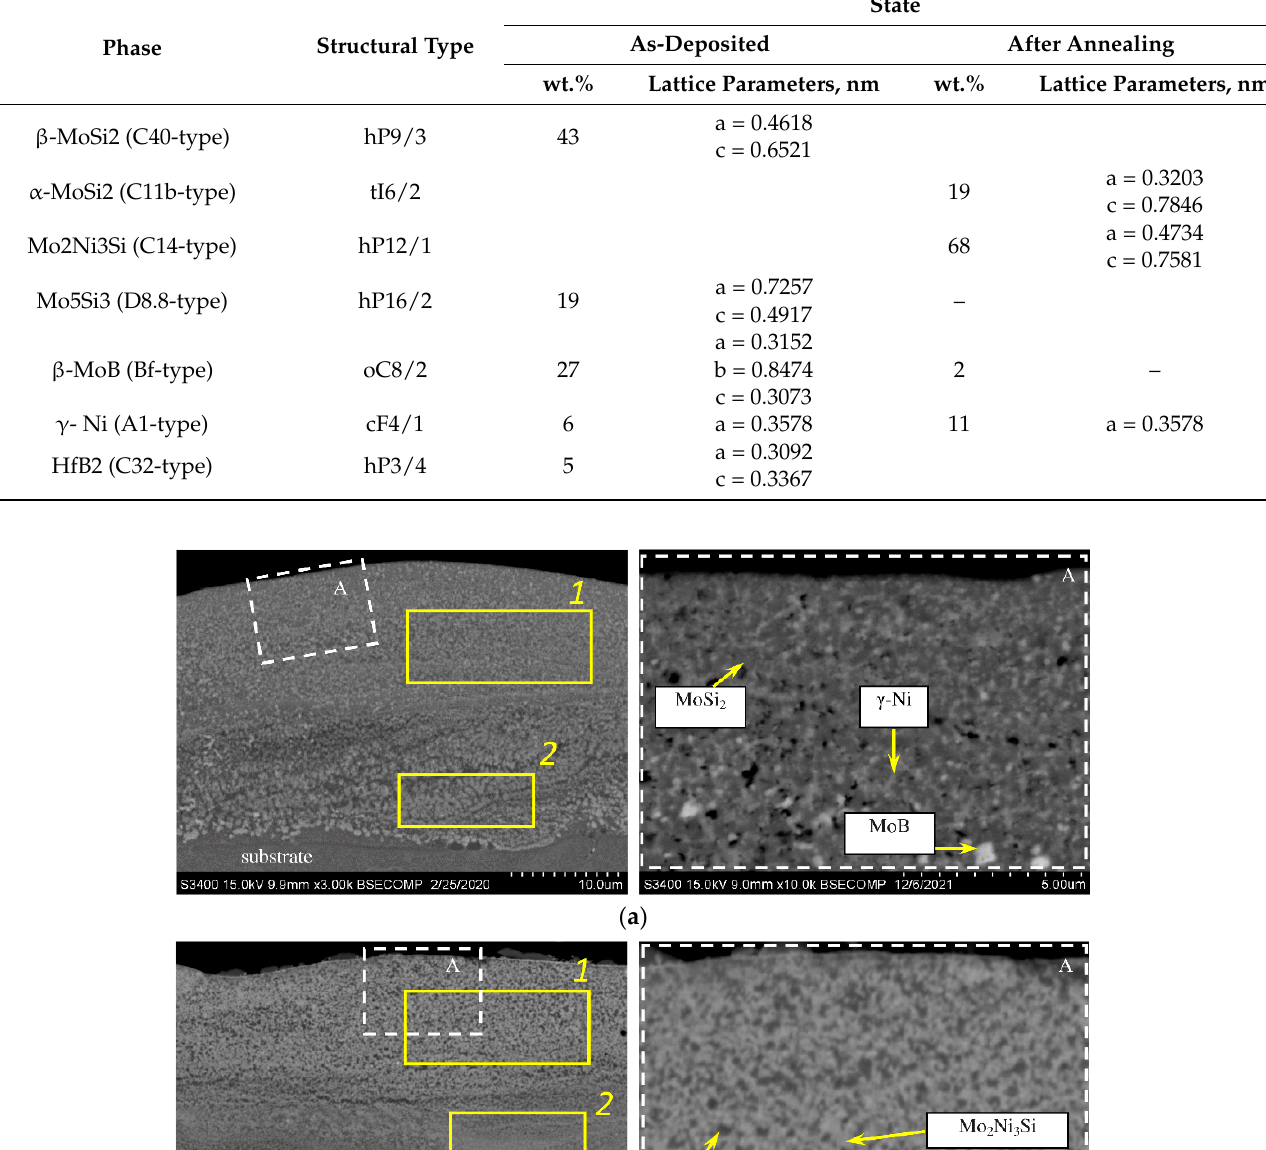
(Figure 2b, inset A) can be identified as the Mo 2 Ni 3 Si Laves phase, which is distributed in the gray matrix of the nickel-based solid solution. The dark gray grains correspond to the MoSi 2 molybdenum disilicide phase. Table 1. Phase composition of the coating.